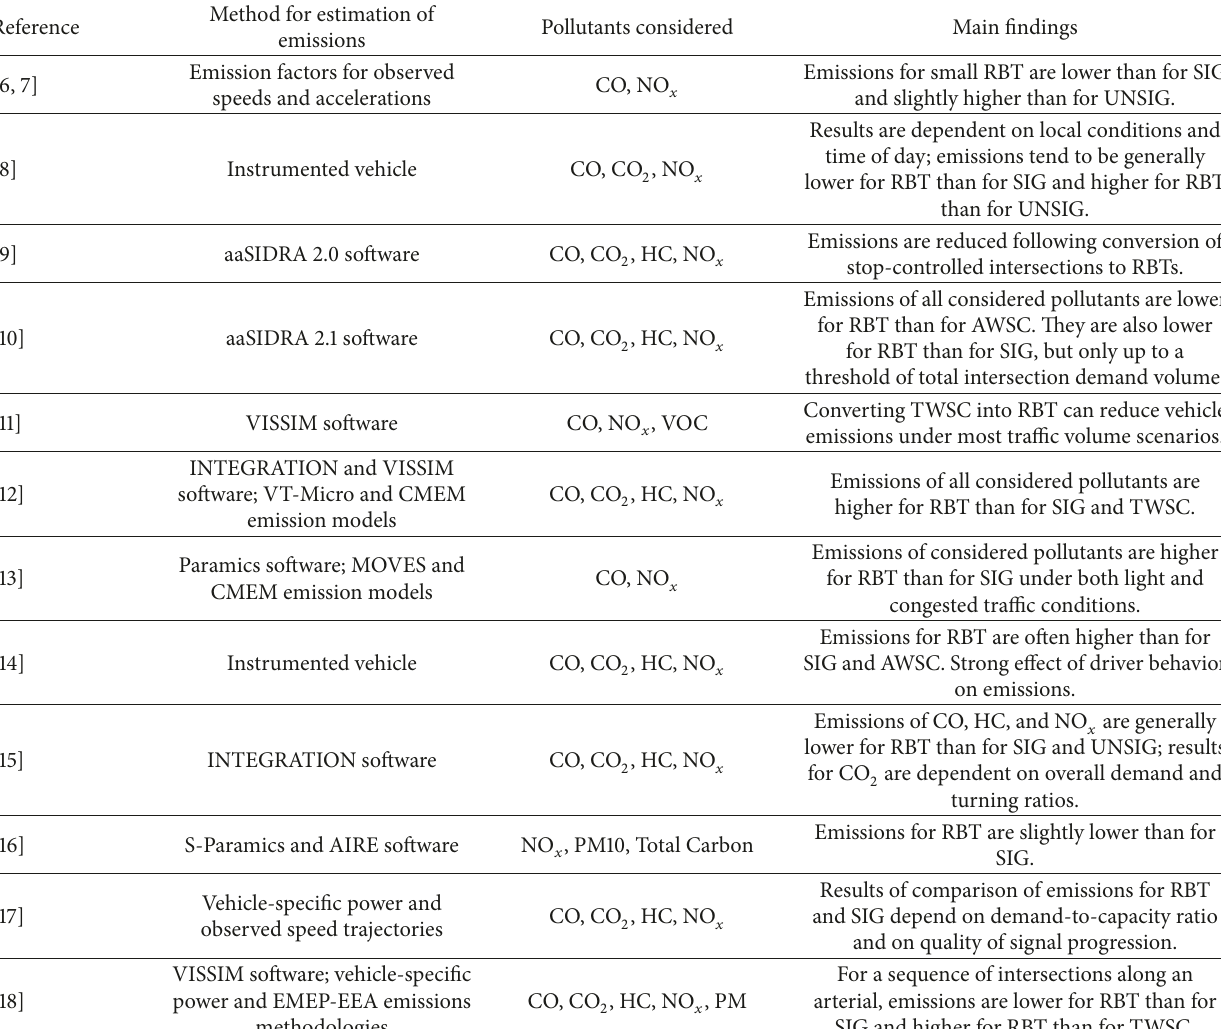
Table1:Summaryofselectedstudiescomparingvehicularemissionsatintersectionsunderdifferenttypesofcontrol(numbersinfirstcolumn correspond to cited references) [4].